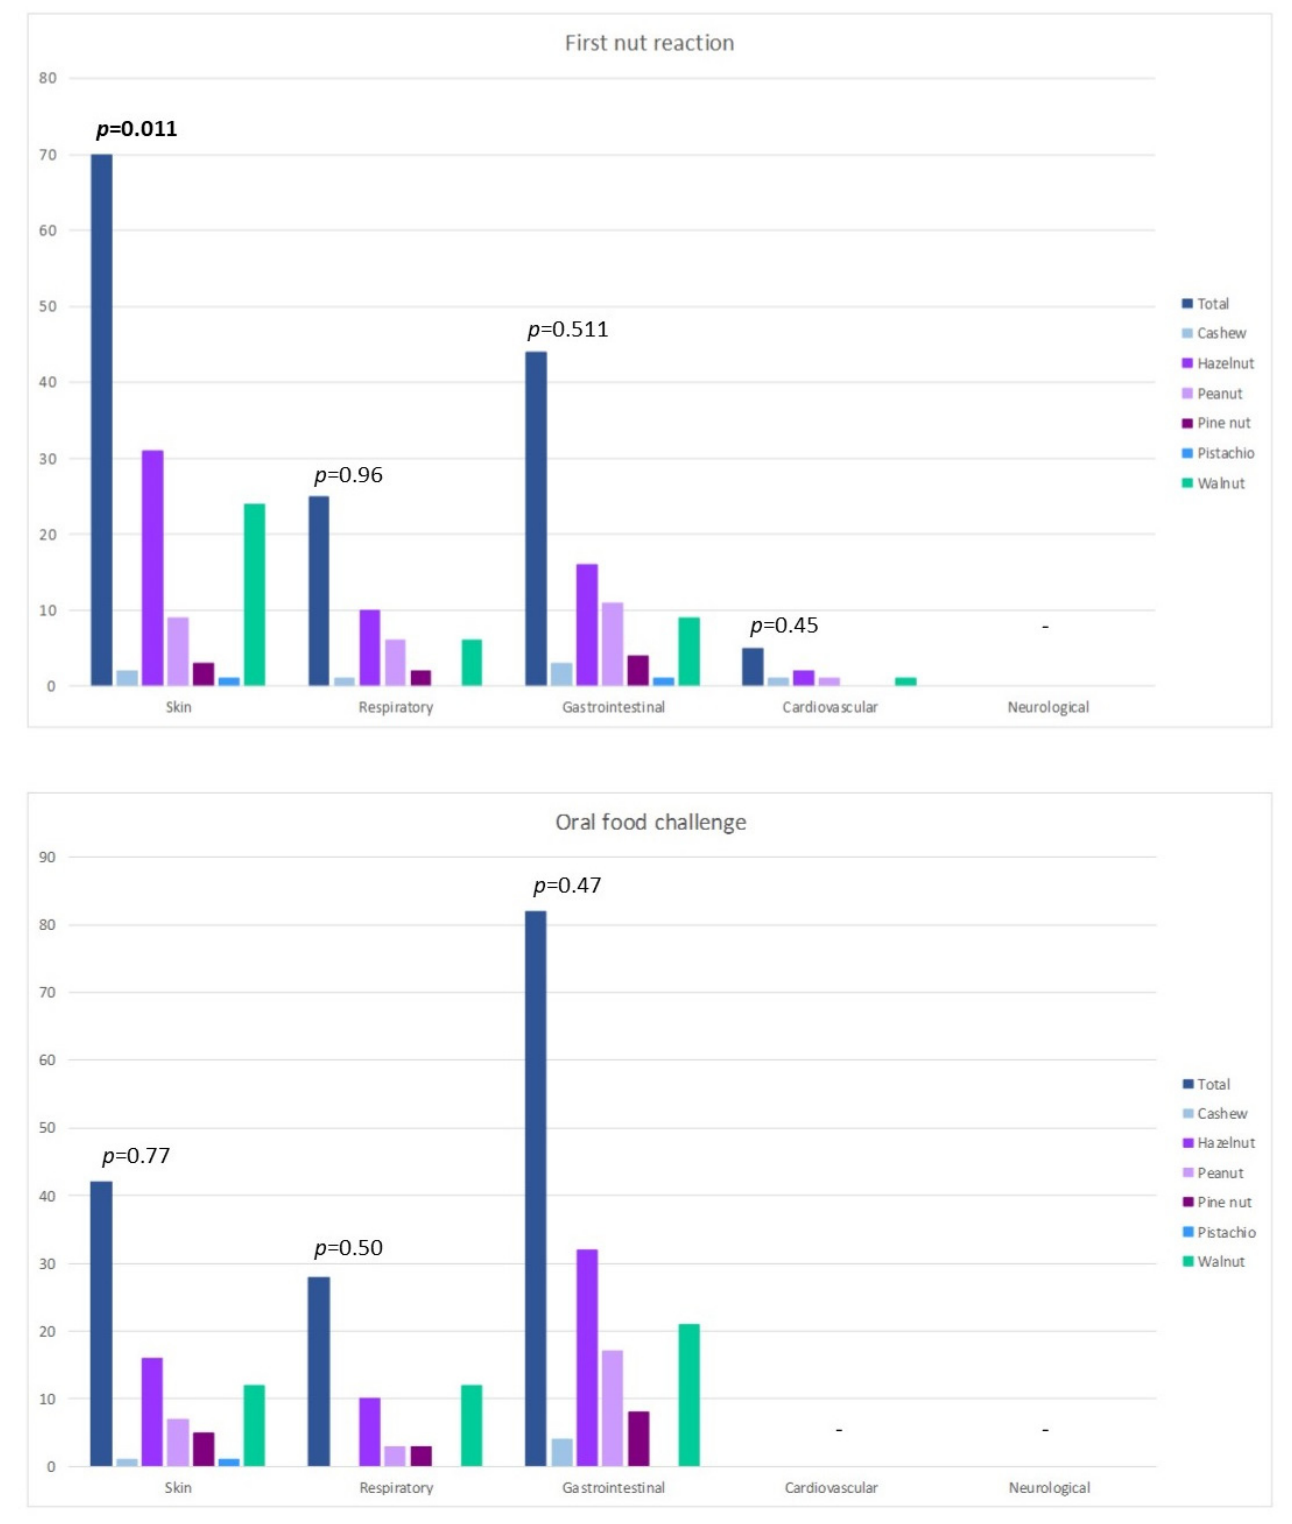
Figure 2. System involvement during the first nut reaction and the positive oral food challenge. In total, 91 out of 113 subjects (81%) with clinical manifestations during OFC presented a mild reaction with single-system involvement. The remaining 22 subjects had anaphylaxis: moderate in 13 children (11%) and severe in 9 children (8%). Table 6 shows the severity